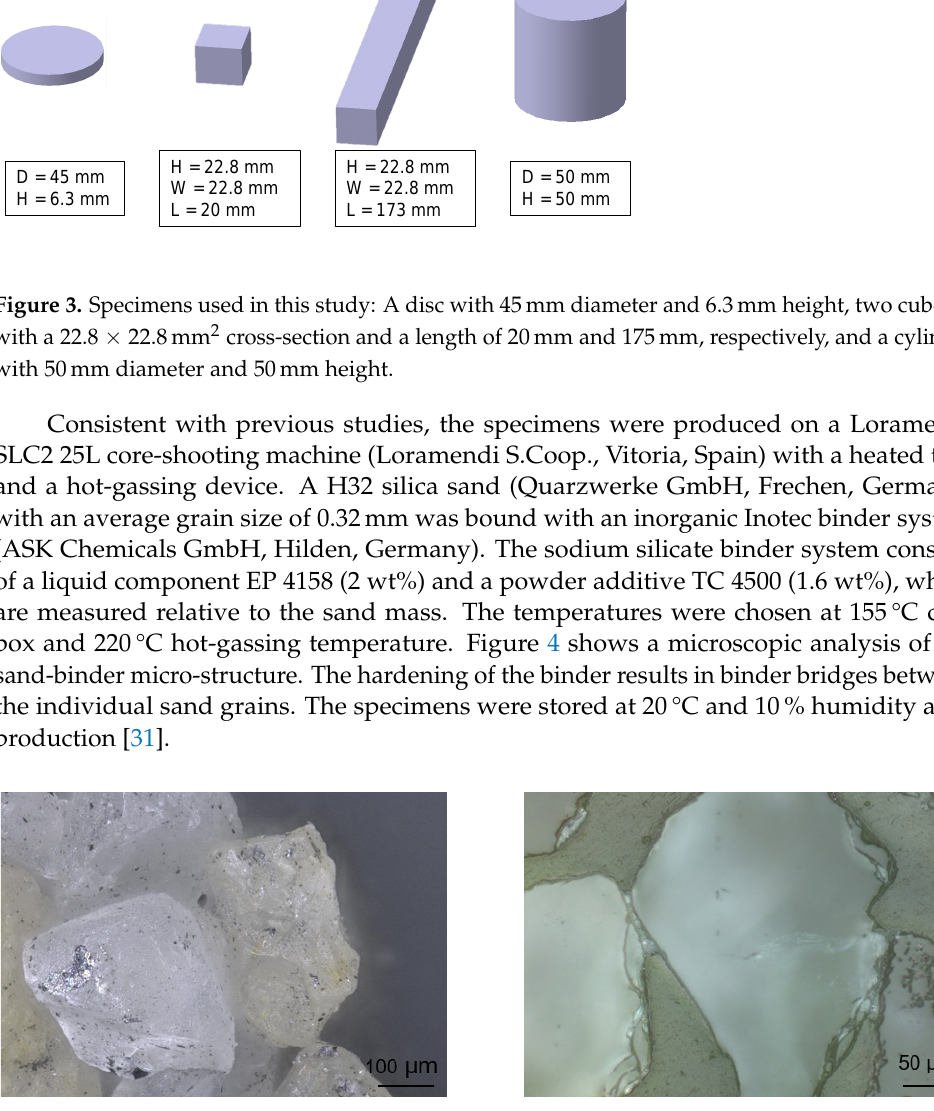
Figure 4. Microscopic analysis of the sand-binder micro-structure. On the left-hand side, an unpro- cessed sand-binder structure is depicted, while it is polished on the right